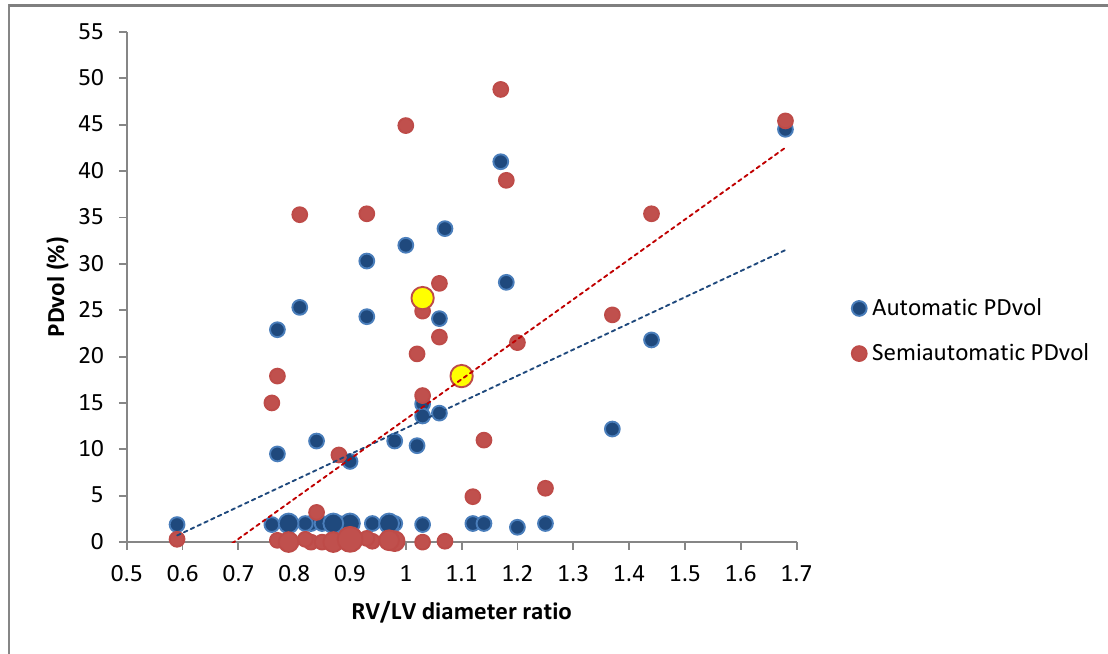
Figure 6. Scatterplot of right ventricular-to-left ventricular (RV/LV) diameter ratio and perfusion defect volume (PDvol) ( n = 43). Line of best fit is shown with a dotted line. The slightly larger blue and red dots represent 2 or 3 patients, depending on the dot size. The yellow dots represent patients with identical automatic and semiautomatic PDvol.